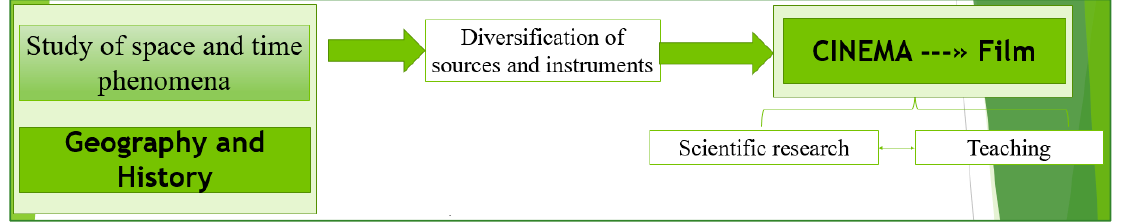
Figure 1. Film regarding Geography and History. (Self-made,